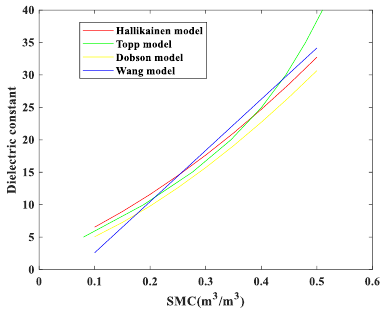
Figure 5 . The four soil models on American clay loam （ C=0.33 ， S=0.33 ） .